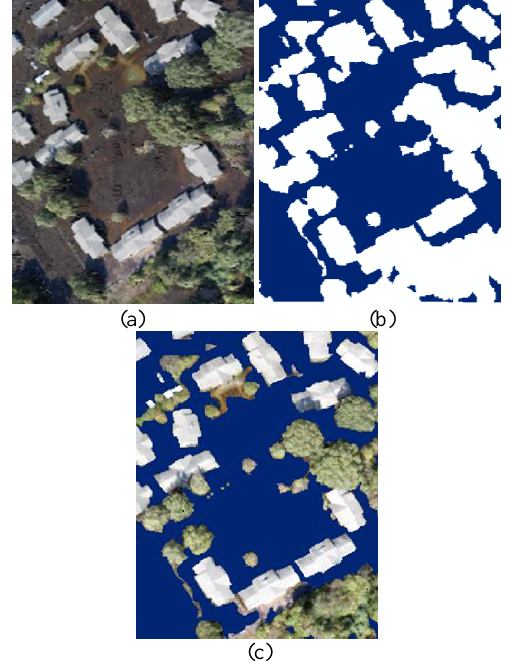
Figure 5. (a) 3D flood map (SfM); (b) FCN-8s extraction result; (c) Overlaid